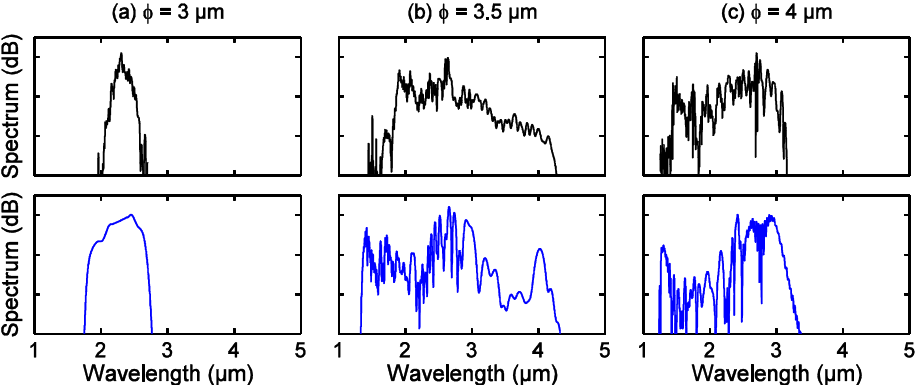
Figure 13. (Top panels) Optimized SC spectra recorded with 12-cm-long segments of tellurite step-index fiber with a distinct core diameter, namely ( a ) 3 µ m, ( b ) 3.5 µ m, and ( c ) 4 µ m. The pump wavelength was fixed to 2300 nm and the input peak power is ~3 kW. (Bottom panels) Corresponding numerical simulations are shown with dashed blue lines.